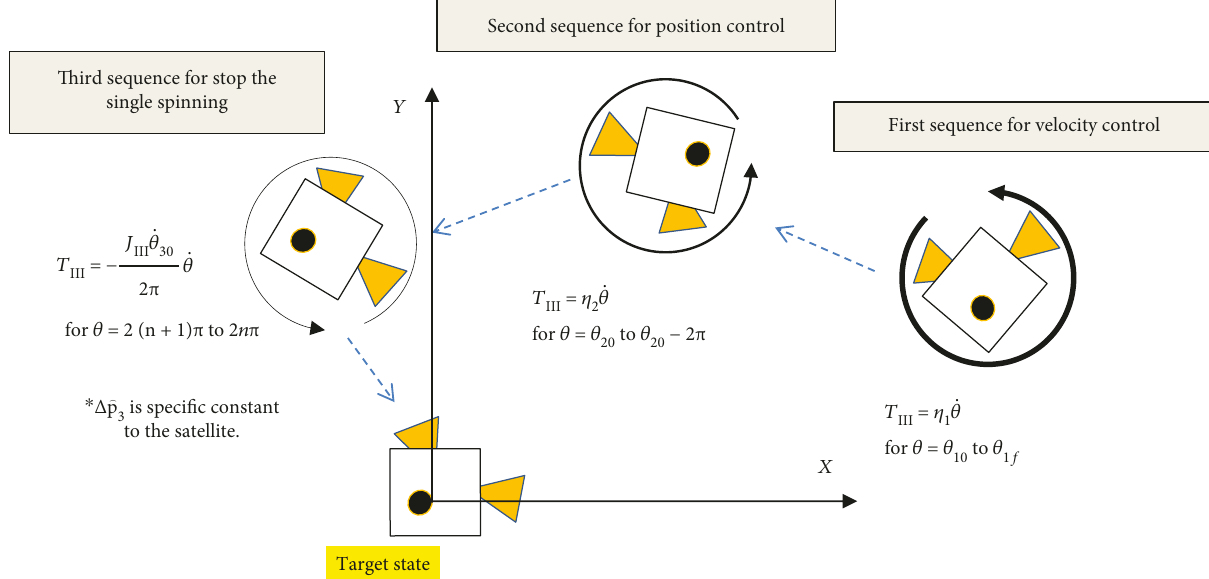
Figure 5: Schematic images of motion planning with the three